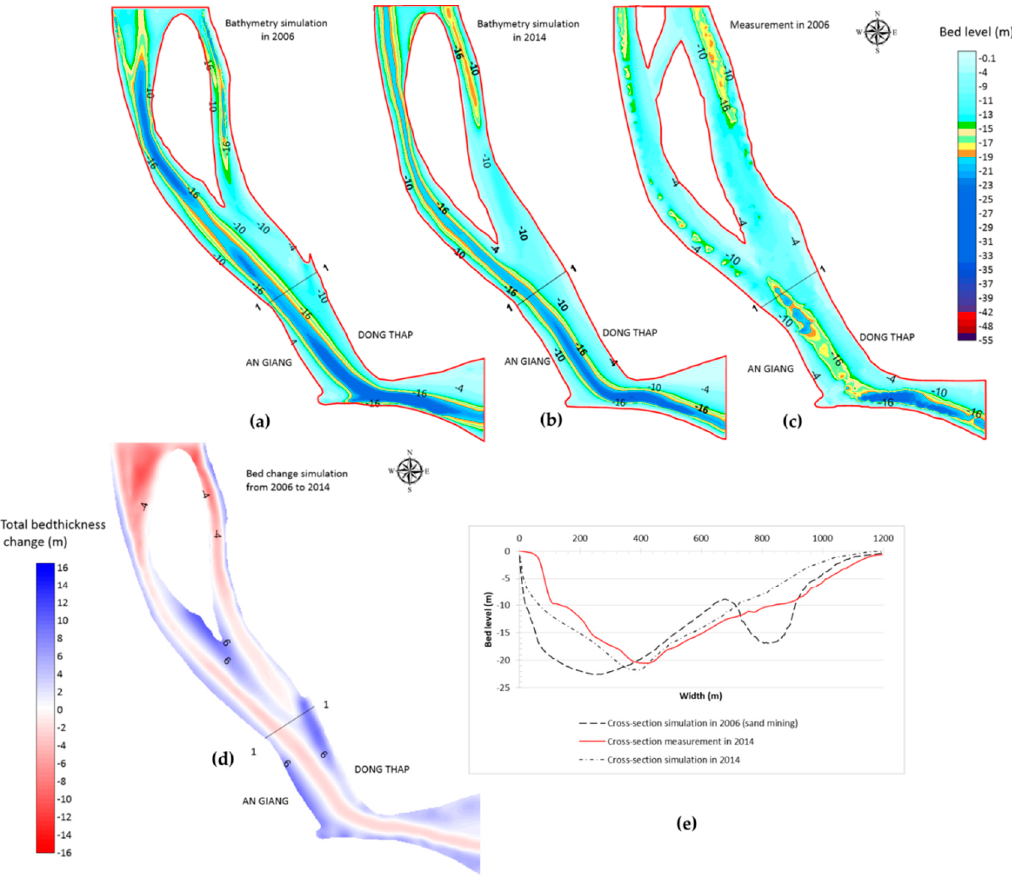
Figure 15. Simulation of the bed changes over the period of 8 years from 2006 to 2014: ( a , b ) results of the simulations for 2006 and 2014, respectively; ( c ) riverbed measurements for 2014; ( d ) bed change simulations during the period; ( e ) a comparison graph of simulations and measurements at cross-section 1.1.